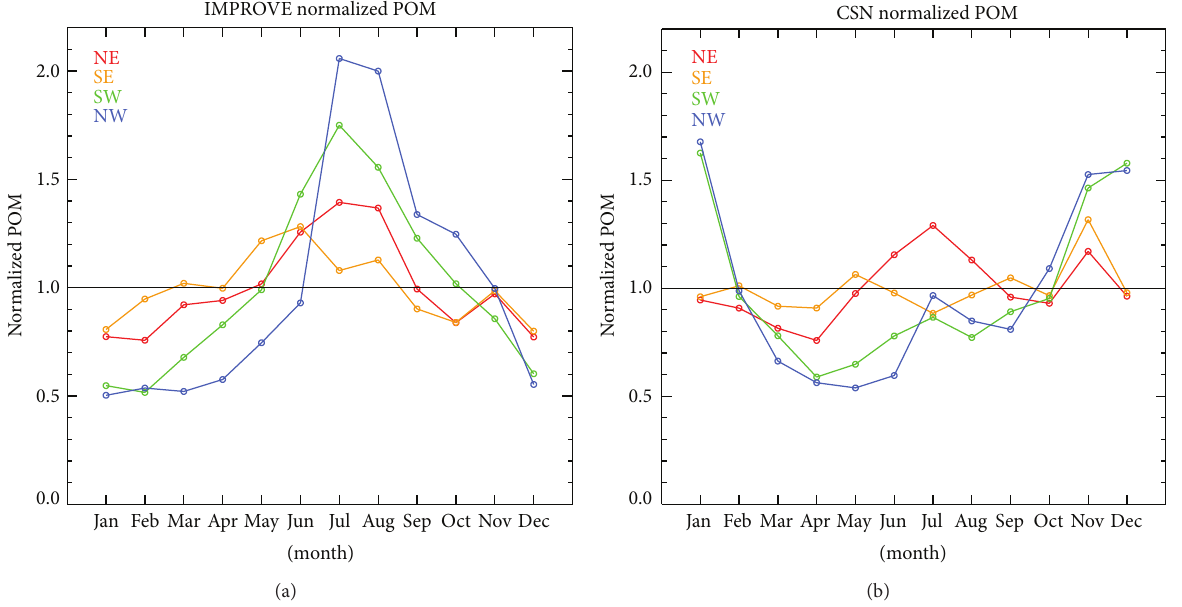
Figure 5: 2007–2010 regional monthly mean normalized (by annual mean) PM 2.5 particulate organic matter (POM) for (a) IMPROVE and (b) CSN. Regions correspond to the Northeast (NE), Southeast (SE), Southwest (SW), and Northwest